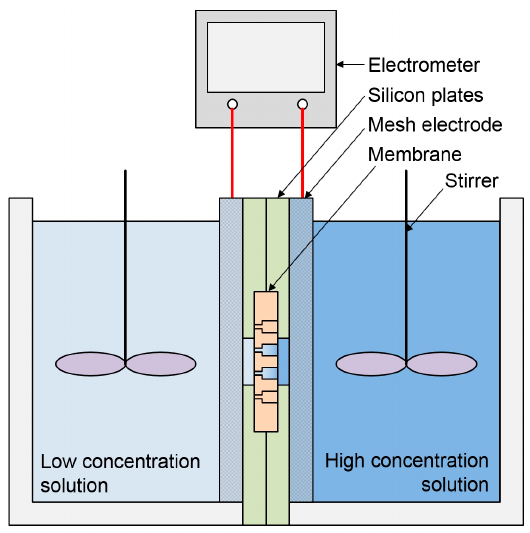
Figure 4. Schematic diagram of the experimental apparatus. Table 2. Combinations of ion concentrations used in the study.